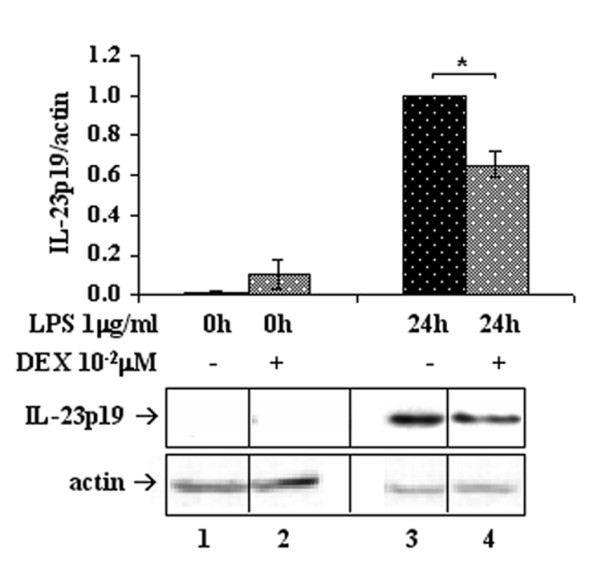
DEX affects IL-23 protein levels. DEX (0.01 μM) reduces IL-23p19 protein production. IL-23p19 protein was analyzed by western immunoblotting of Mφ stimulated with LPS (upper panel) for the times indicated. Data obtained from densitometric analyses were normalized on respective actin signals (lower panel). Images are representative of three independent experiments and data are reported in bar graphs as fold changes relative to the peak samples; n = 3. *p < 0.05